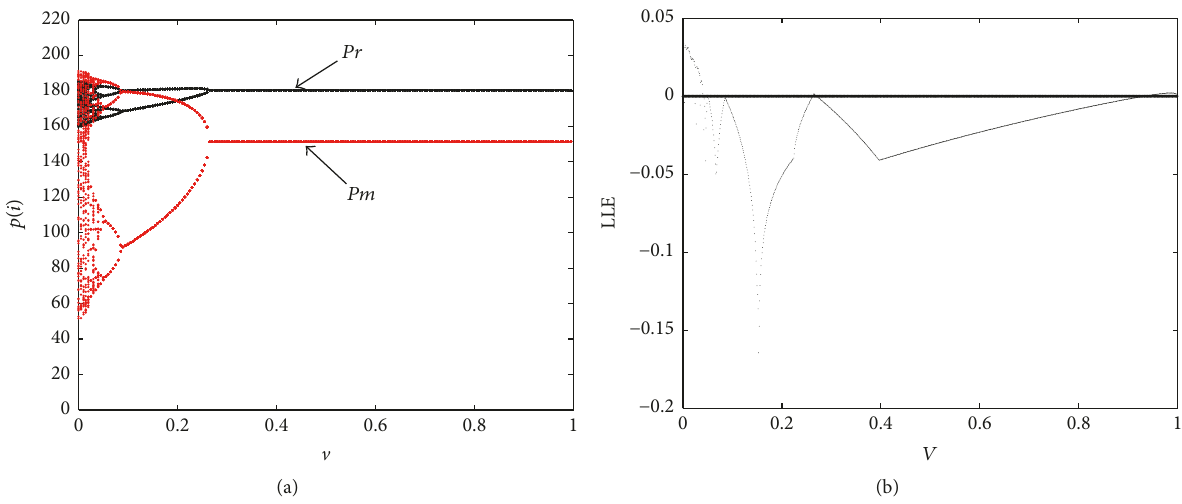
Figure 11: Bifurcation diagram and Lyapunov exponent of system (11) with V ∈ (0,1) , 𝛼 1 = 0.005 , and 𝛼 2 = 0.022